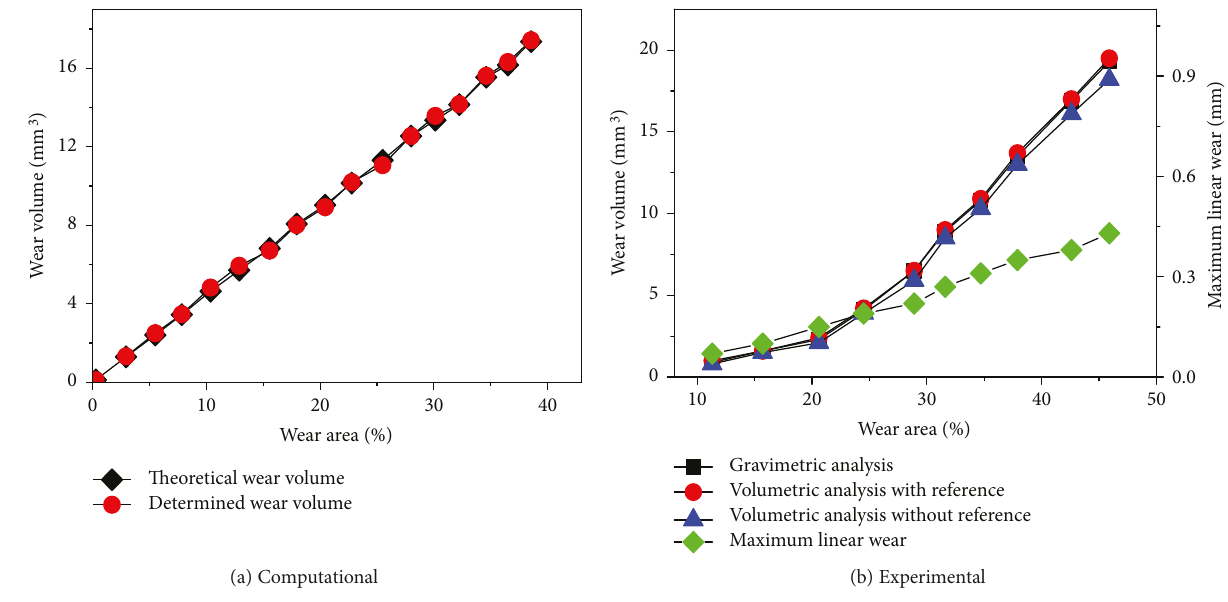
Figure 6: Computational and experimental simulated volume removal test